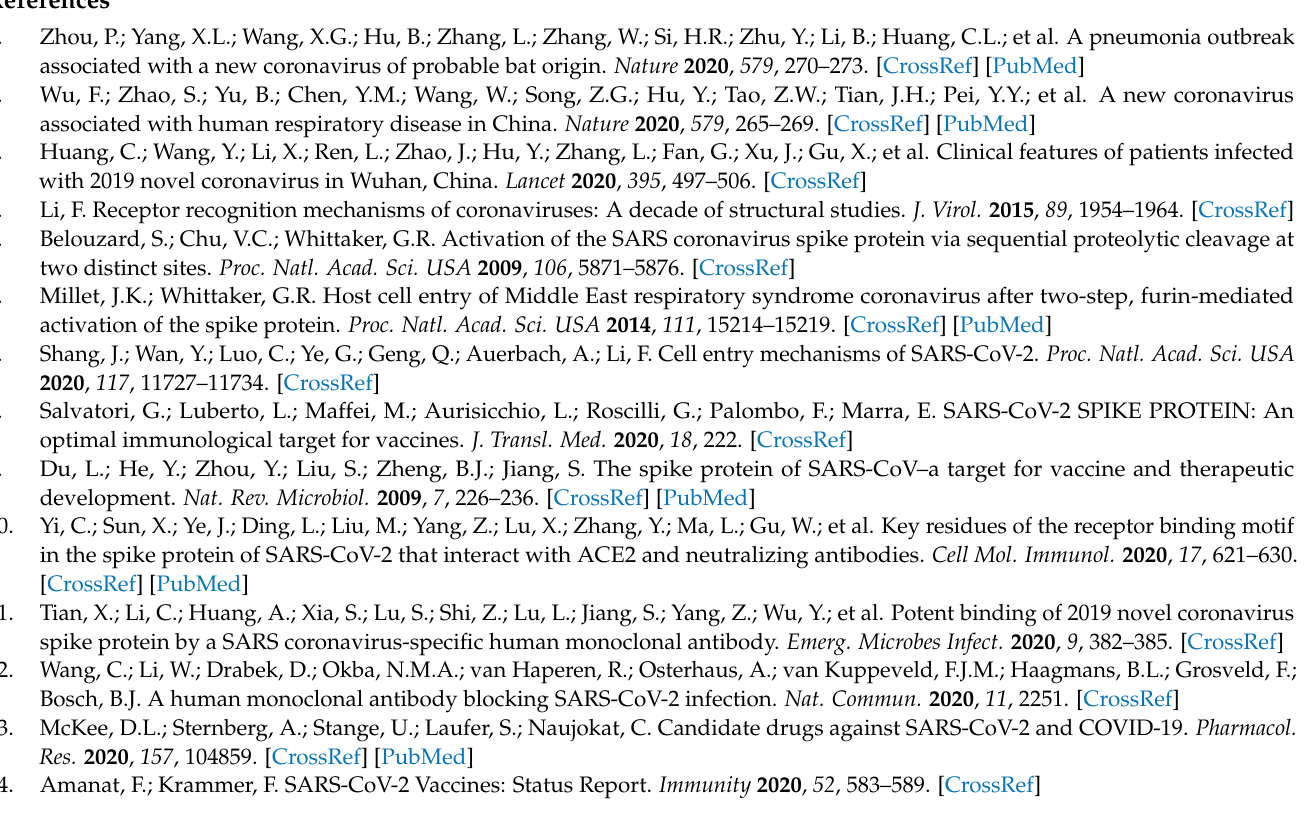
Pre-fusion state: C α RMSD values versus time. Figure S3. Pre-fusion state: RMSF values per residue. Figure S4. Pre-fusion state: Average number of hydrogen bonds versus time. Figure S5. Pre-fusion state: Potential energy versus time. Figure S6. Pre-fusion state: Electrostatic (ELE) and Lennard Jones (LJ) energies versus time. Figures S7–S8. Post-fusion state: C α RMSD values versus time. Figure S9. Post-fusion state. RMSF per residue. Figure S10. Post-fusion state: Average number of hydrogen bonds versus time. Figure S11. Post-fusion state: Potential energy versus time. Figure S12. Post-fusion state: Electrostatic (ELE) and Lennard Jones (LJ) energies versus time. Figure S13. Buried surface area along the MD simulations for the wt and D936Y mutant post-fusion